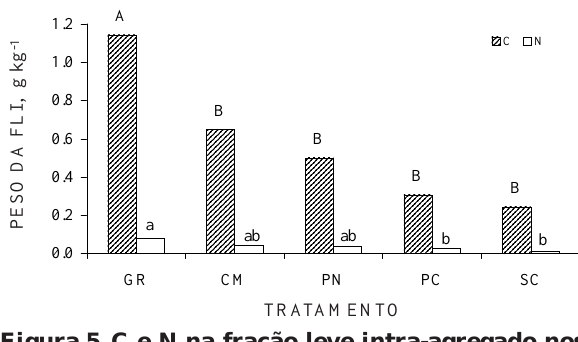
Figura 5. C e N na fração leve intra-agregado nos diferentes tipo de preparo do solo e cobertura vegetal. Médias seguidas da mesma letra maiúscula, para teor de C total, e da mesma letra minúscula, para teor de N total, não diferem entre si (Tukey p <